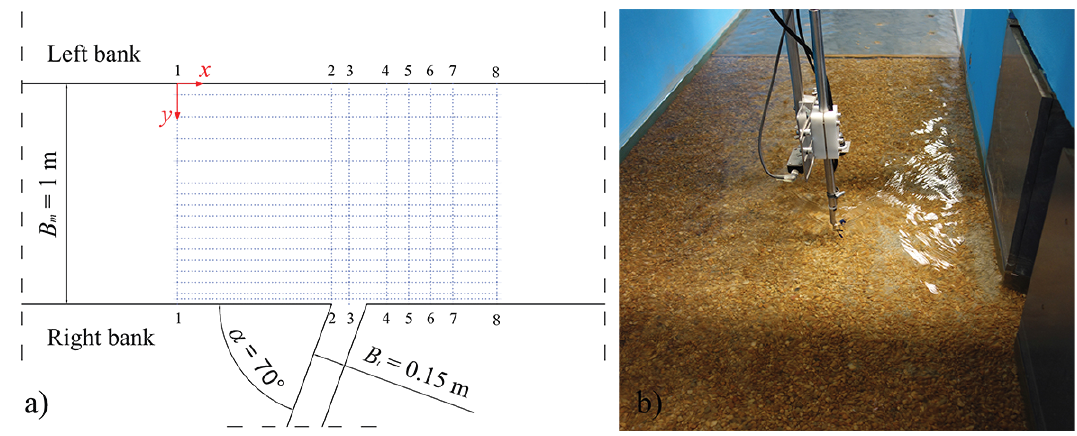
Figure 2. ( a ) plan view and ( b ) photograph of the experimental facility used by Birjukova et al. [23] with the measurement grid. Streamwise coordinates of the measured cross-sections: x 1 = 0 m, x 2 = 0.7 m, x 3 = 0.78 m, x 4 = 0.95 m, x 5 = 1.05 m, x 6 = 1.15 m, x 7 = 1.25 m, x 8 = 1.45